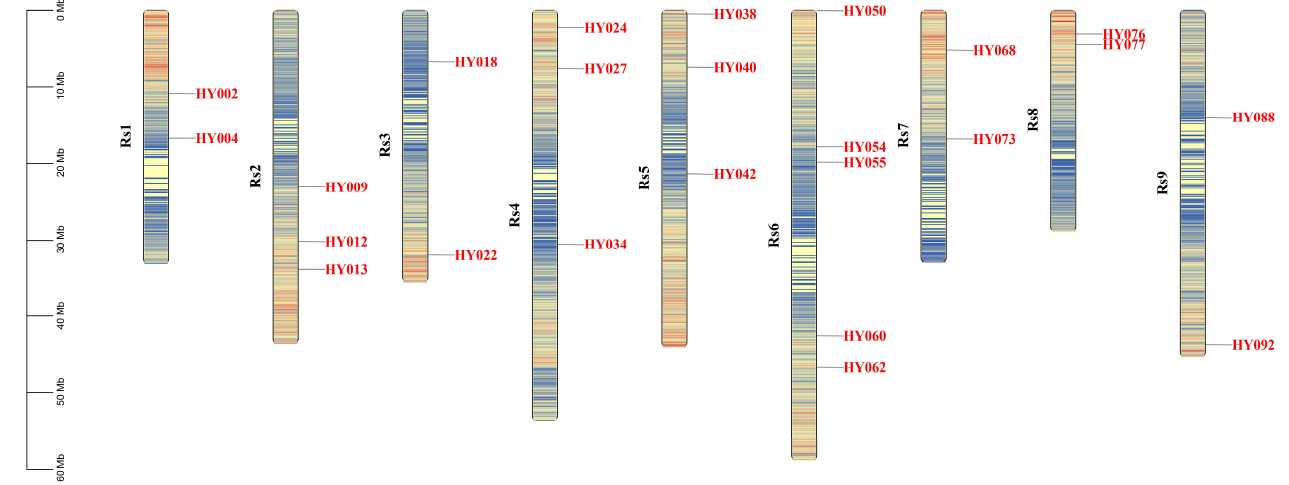
Figure 1. Distribution of 24 SV markers on nine chromosomes.